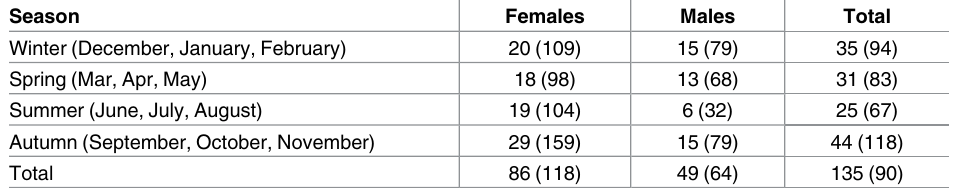
Table 1. Seasonality of SITBs by sex among the cases visited in the EDs in the years2005 and 2006: cases and, in parenthesis, incidence per 100,000.